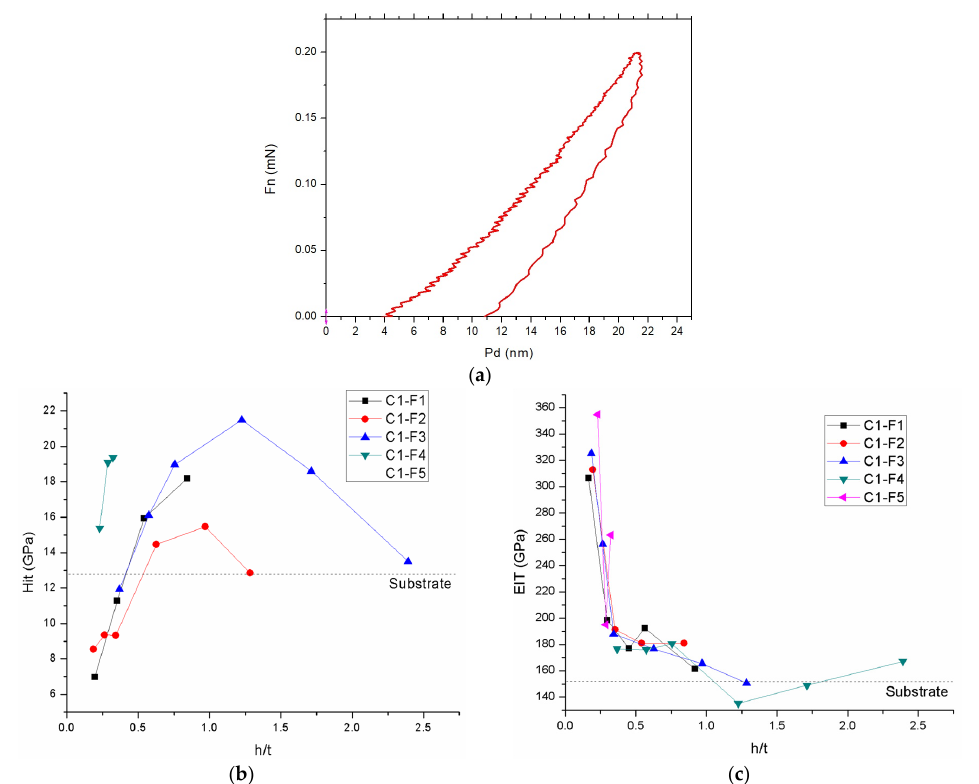
Figure 5. Typical load ‐ displacement curve for carbon thin films synthesized by PLD in vacuum ( a ), mean hardness ( b ) and elastic modulus ( c ) as a function of applied load.